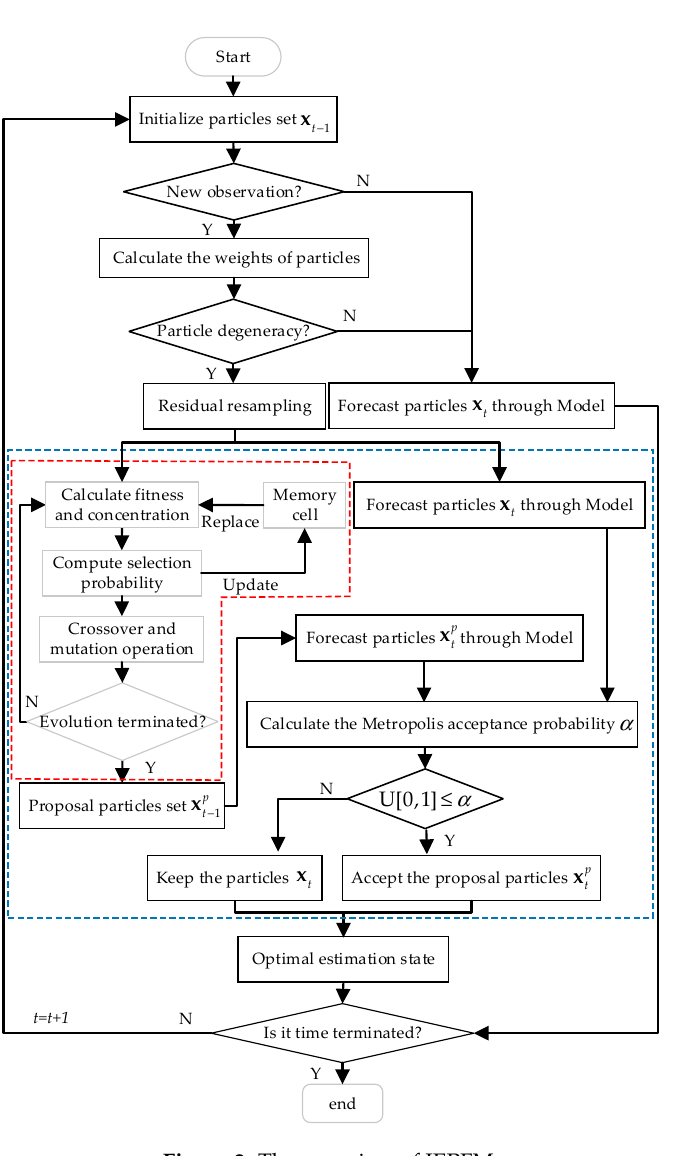
Figure 2. The overview of IEPFM.